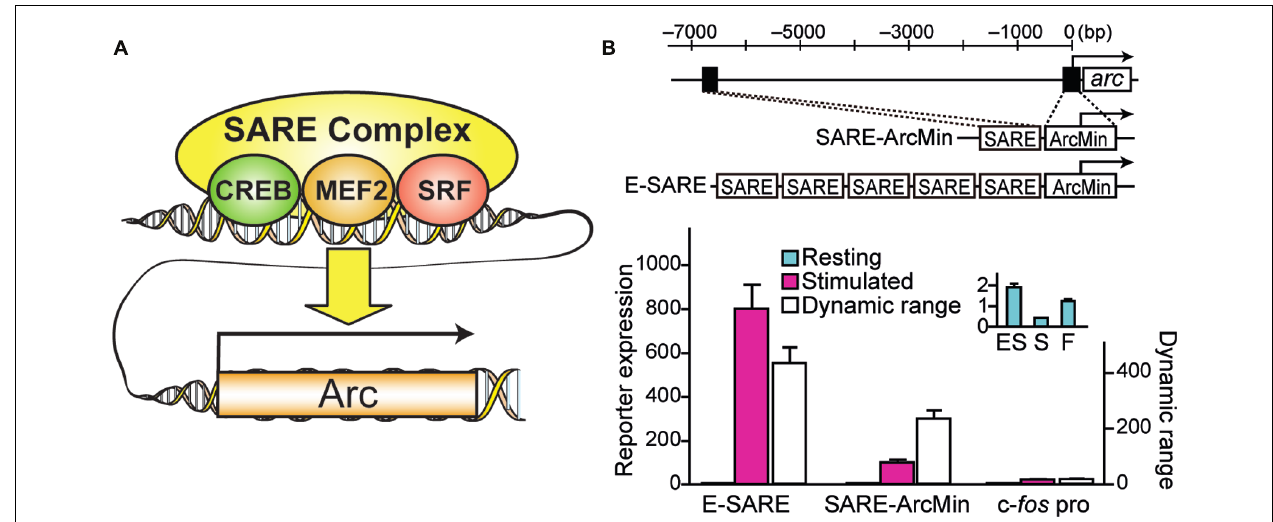
connecting SARE elements in tandem. Bottom, comparison of E-SARE with SARE-ArcMin and c- fos promoters by luciferase reporter assay in cultured neurons under resting (blue) and stimulated (pink) conditions. Dynamic ranges (calculated based on the ratio between stimulated and resting conditions; white) are also shown. Inset, expanded values obtained under resting conditions. Adapted from Kawashima etal.